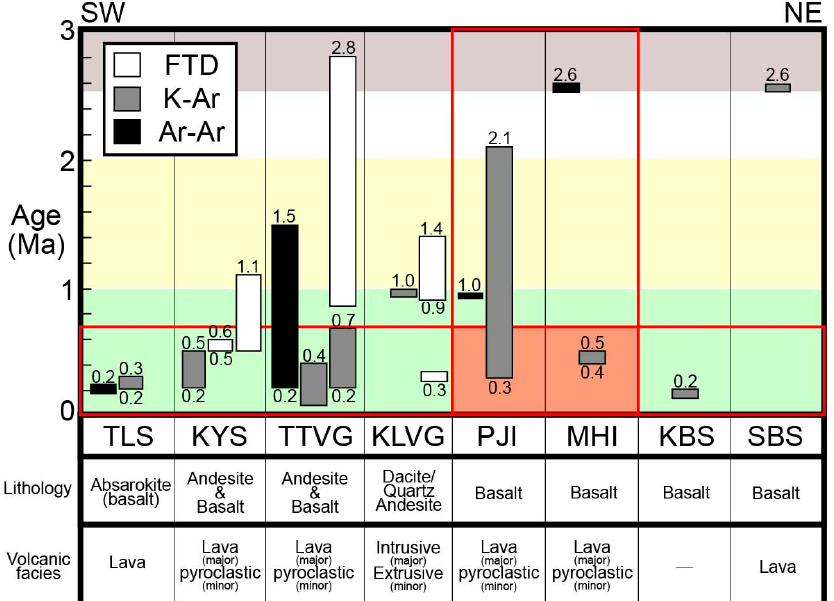
Figure 2. Radiometric age data for the volcanic fields in the NTVZ [15]. FTD: fission track dating; TLS: Tsaolingshan; KYS: Kuanyinshan; TTVG: Tatun Volcanic Group; KLVG: Keelung Volcanic Group; PJI: Pengjia Islet; MHI: Mianhua Islet; SBS: Sekibisho; KBS: Kobisho. See text for the references.